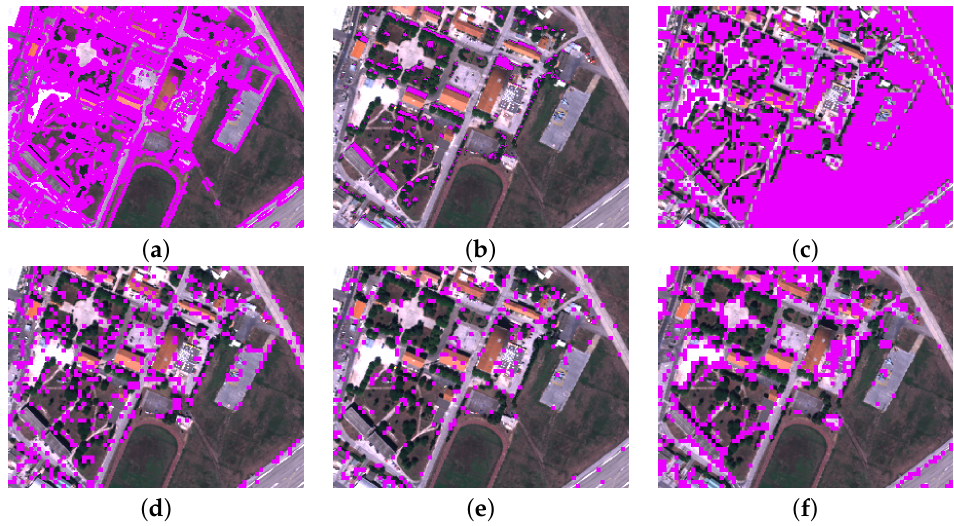
Figure 13. “Toulon” peri-urban dataset: masks corresponding to the located specific pixel groups (pixels belonging to the masks identified in magenta; associated pixel proportions in percent). ( a ) Transitions areas: 50%, ( b ) shadowed pixels: 4%, ( c ) HS pixels with variance < 5: 64%, ( d ) HS pix- els with variance ∈ [ 5 ;10 ] : 14%, ( e ) HS pixels with variance ∈ [ 10 ;15 ] : 7%, and ( f ) HS pixels with variance > 15: